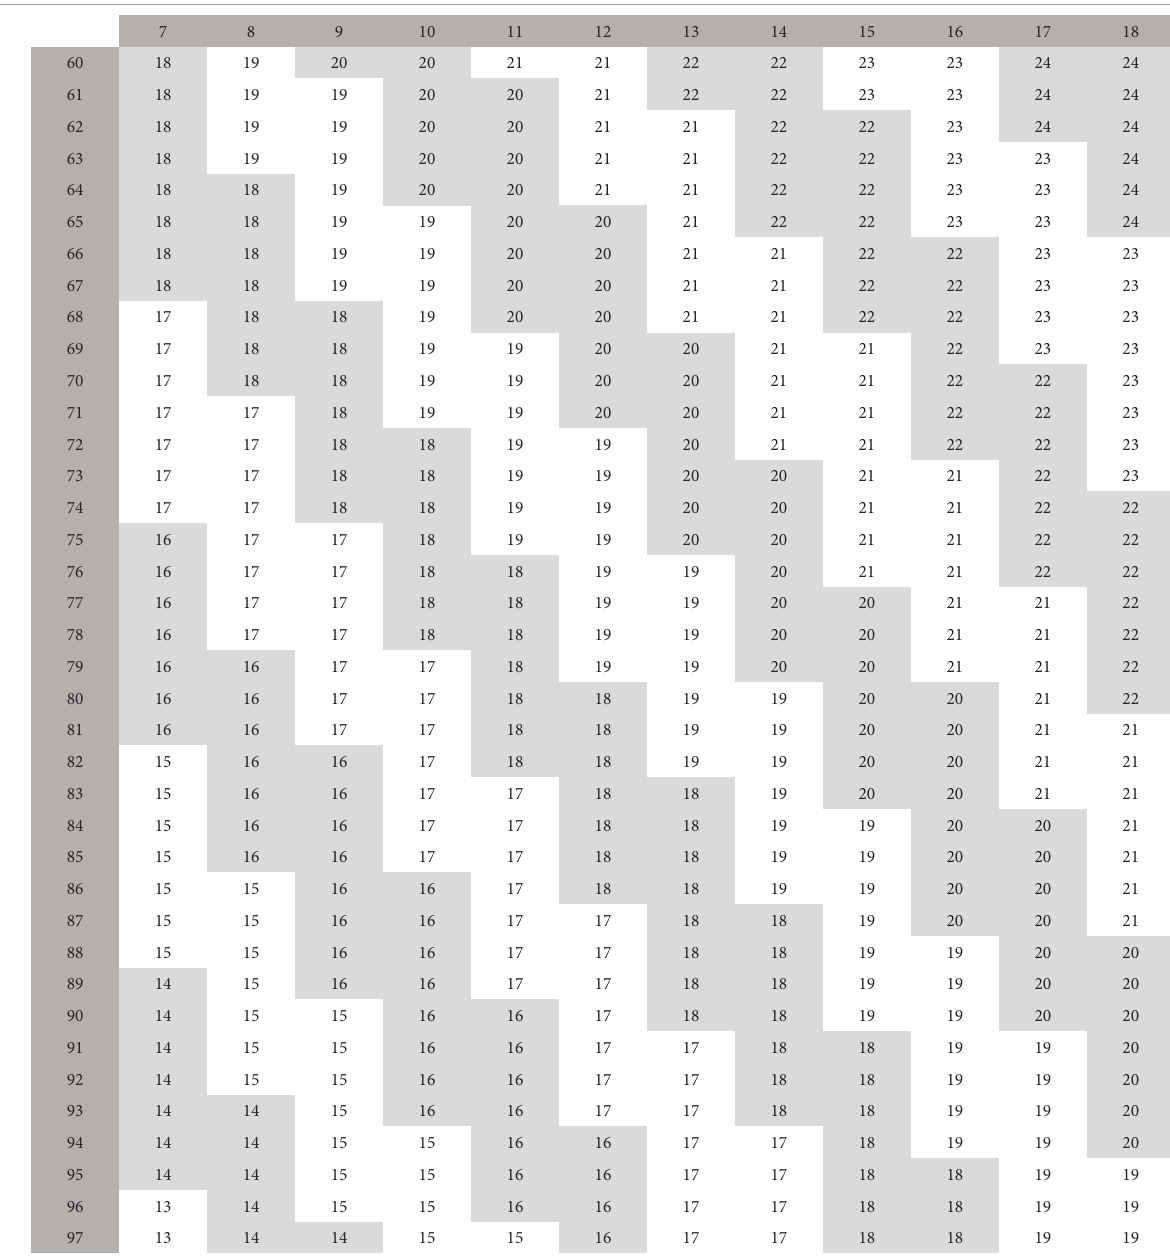
TABLE 3B Highest MoCA-HI total scores just below the 10th percentile for men (z-score ≤